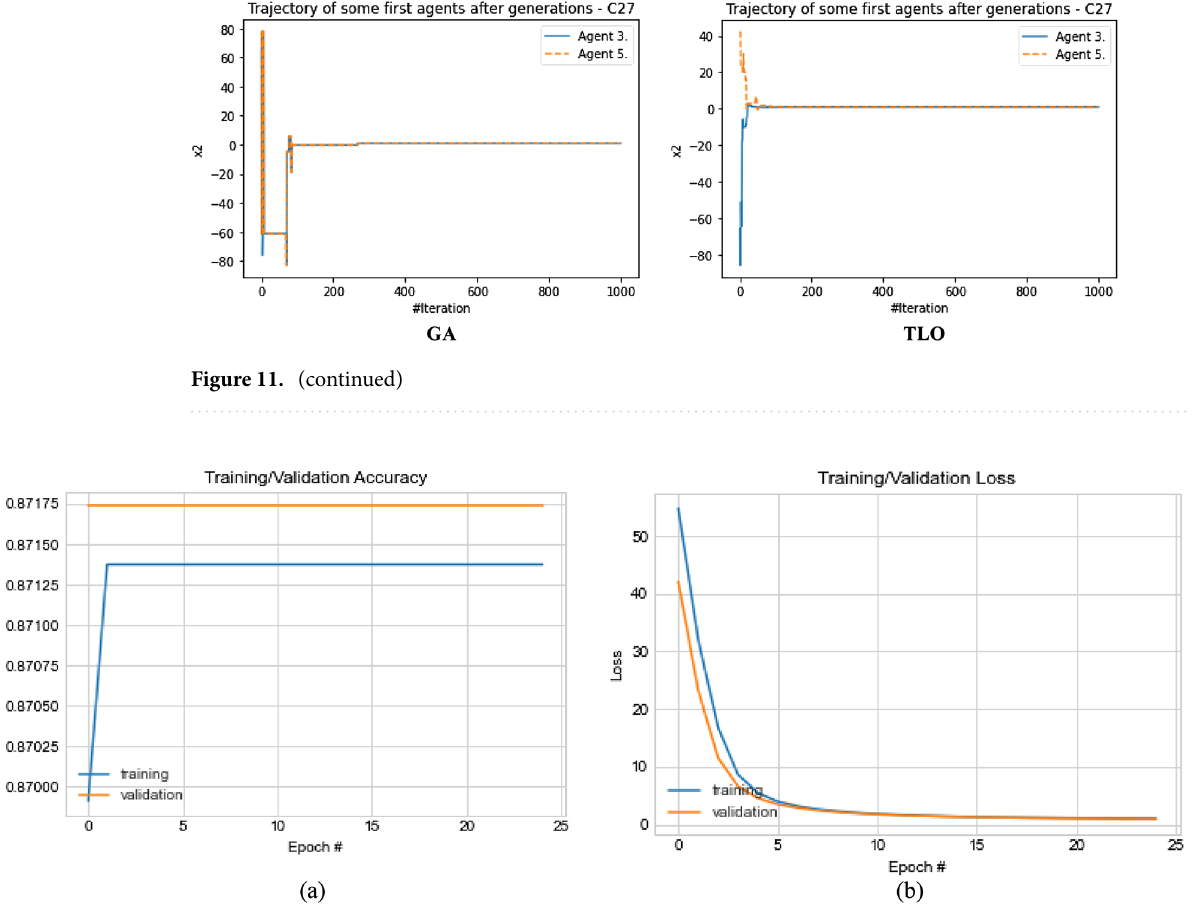
Figure 12. A plot of the values obtained for accuracy for training and evaluation ( a ), and loss function values for training and validation for the CNN model used for feature extraction ( b ).